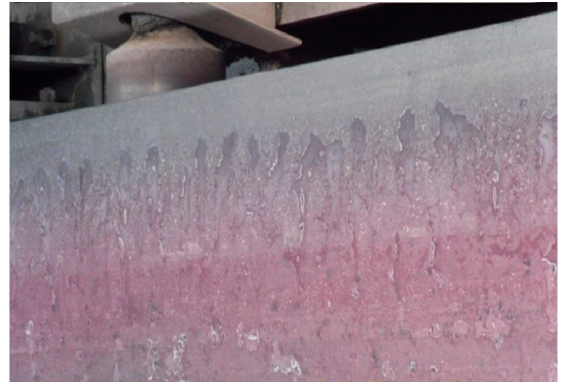
Figure 1. Photograph of surface depressions of the 1.35 wt.% Al-TRIP steel slab.